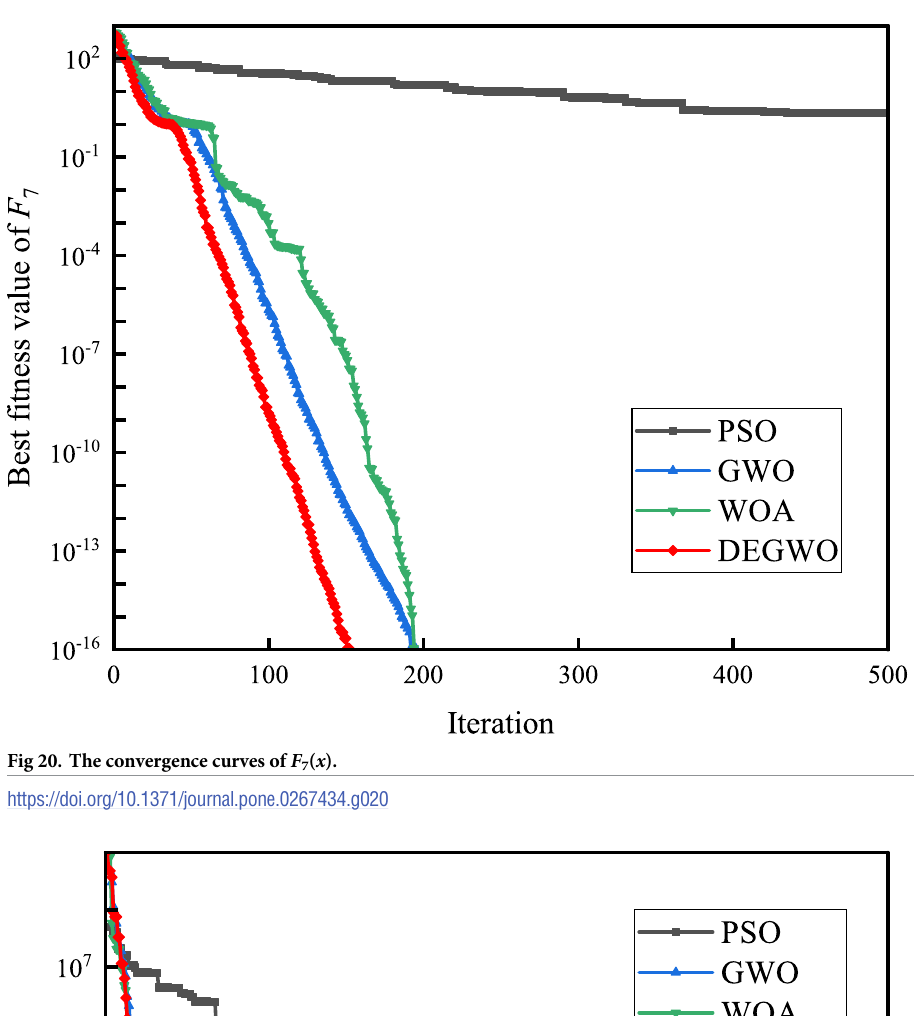
Fig 20. The convergence curves of F 7 ( x ).